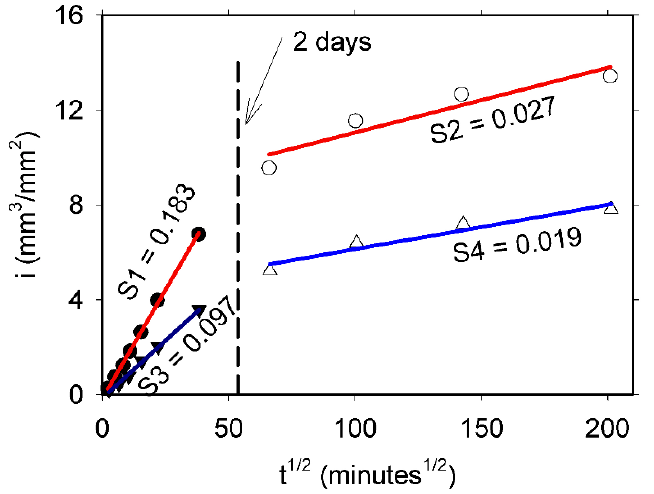
Figure 3. Cumulative water absorption per unit area (i) versus the square root of time for 0.60 (circles) and 0.35 (triangles) w/c ratio mortars. Primary sorptivities S1 and S3 (filled symbols) and secondary sorptivities S2 and S4 (empty symbols) are given in units of mm/min 1/2 .